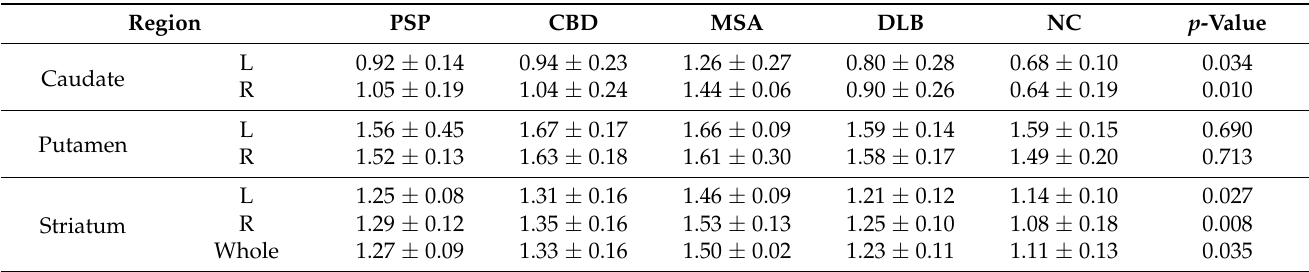
Table 4. Striatal SUVRs of types of atypical